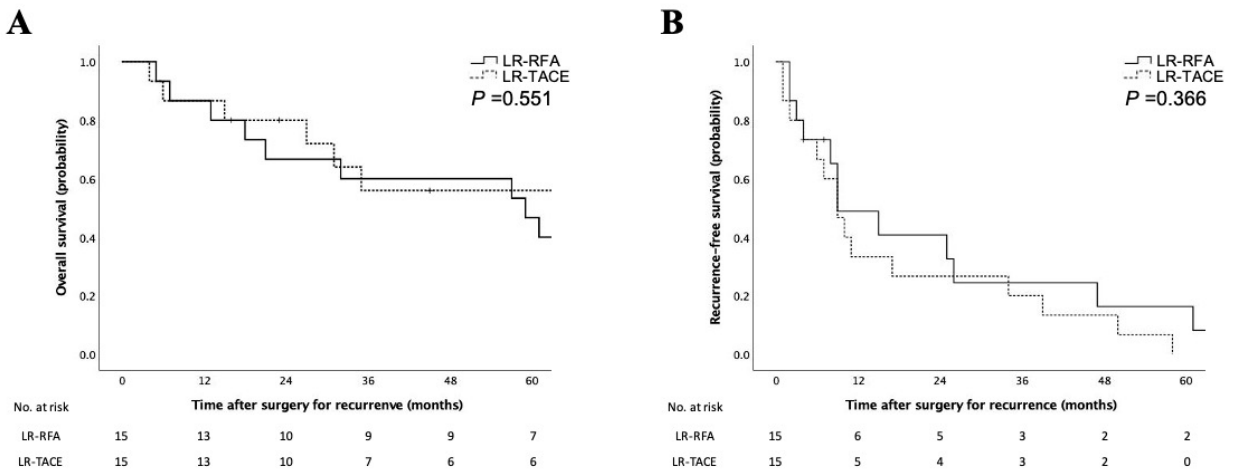
Figure 3. Survival analyses according to the previous locoregional therapy in LR-HCC. Kaplan–Meier curves for overall survival rates ( A ) and recurrence-free survival rates ( B ) of patients according to the previous locoregional therapy in locally recurrent hepatocellular carcinoma. Survival rates were comparable between RFA and TACE before recurrence in the log–rank test. LR-RFA, locally recurrent hepatocellular carcinoma after RFA; LR-TACE, locally recurrent hepatocellular carcinoma after TACE.